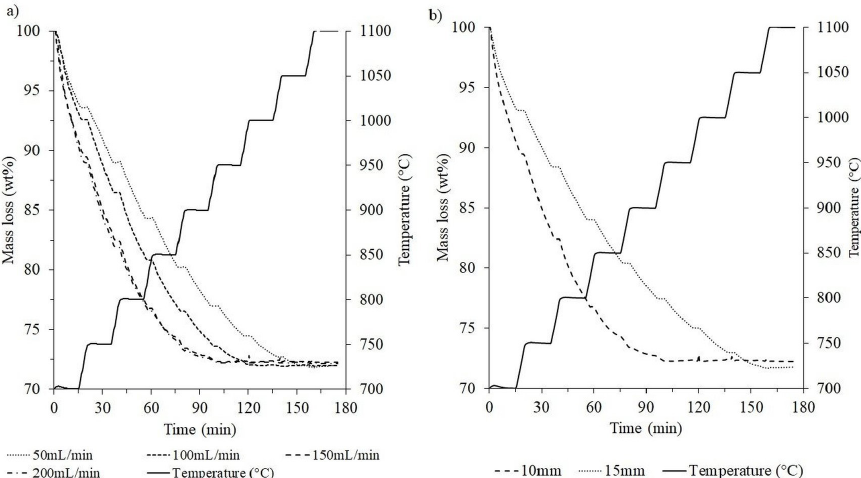
Figure 10. Thermogravimetric tests. a) Influence of CO flow on the reduction of the iron-ore pellet; b) influence of pellet diameter on the reduction